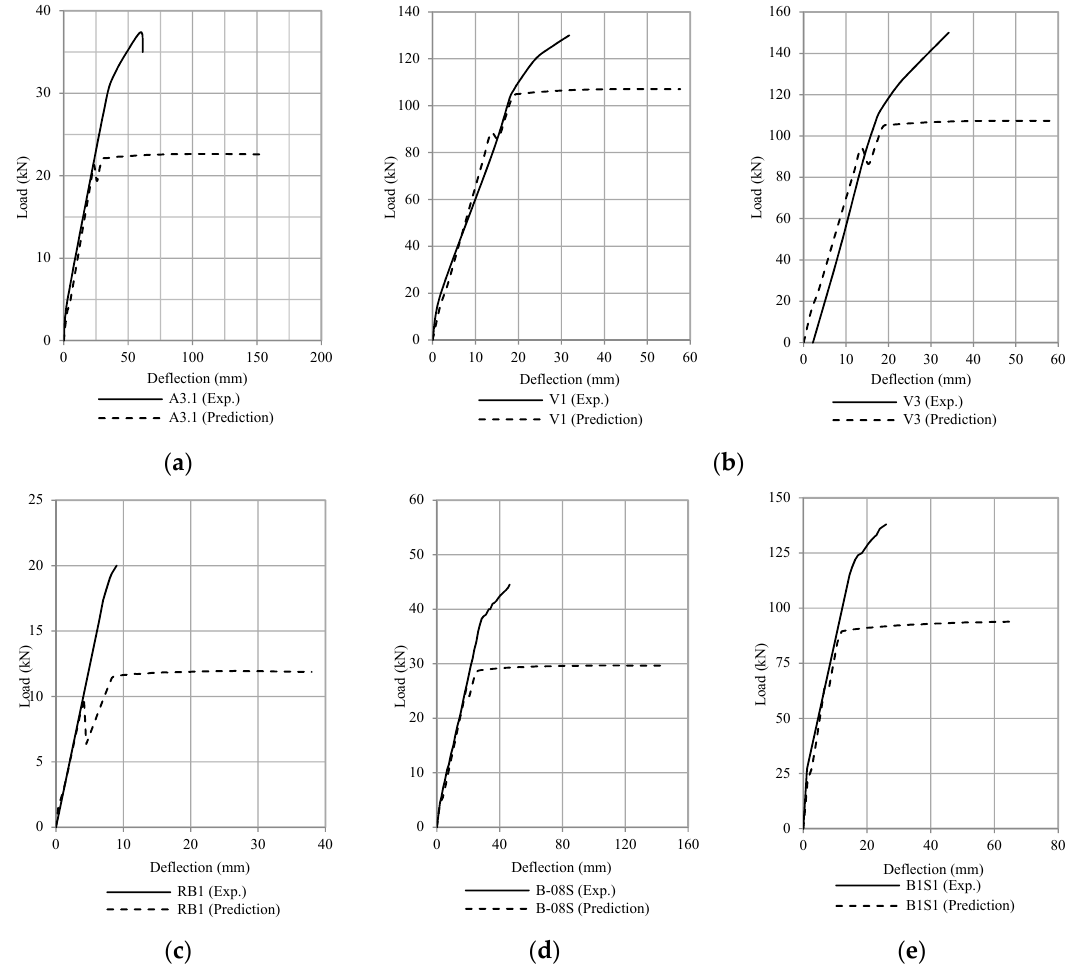
Figure 20. Comparison of the debonding load between the experimental results and the prediction (Type 2. debonding failure occurs before the yielding of tensile reinforcement) ( a ) Spadea et al. [3], ( b ) Shehata et al. [5], ( c ) Benjeddou et al. [12], ( d ) Kotynia et al. [13], and ( e ) Fu et al. [17].